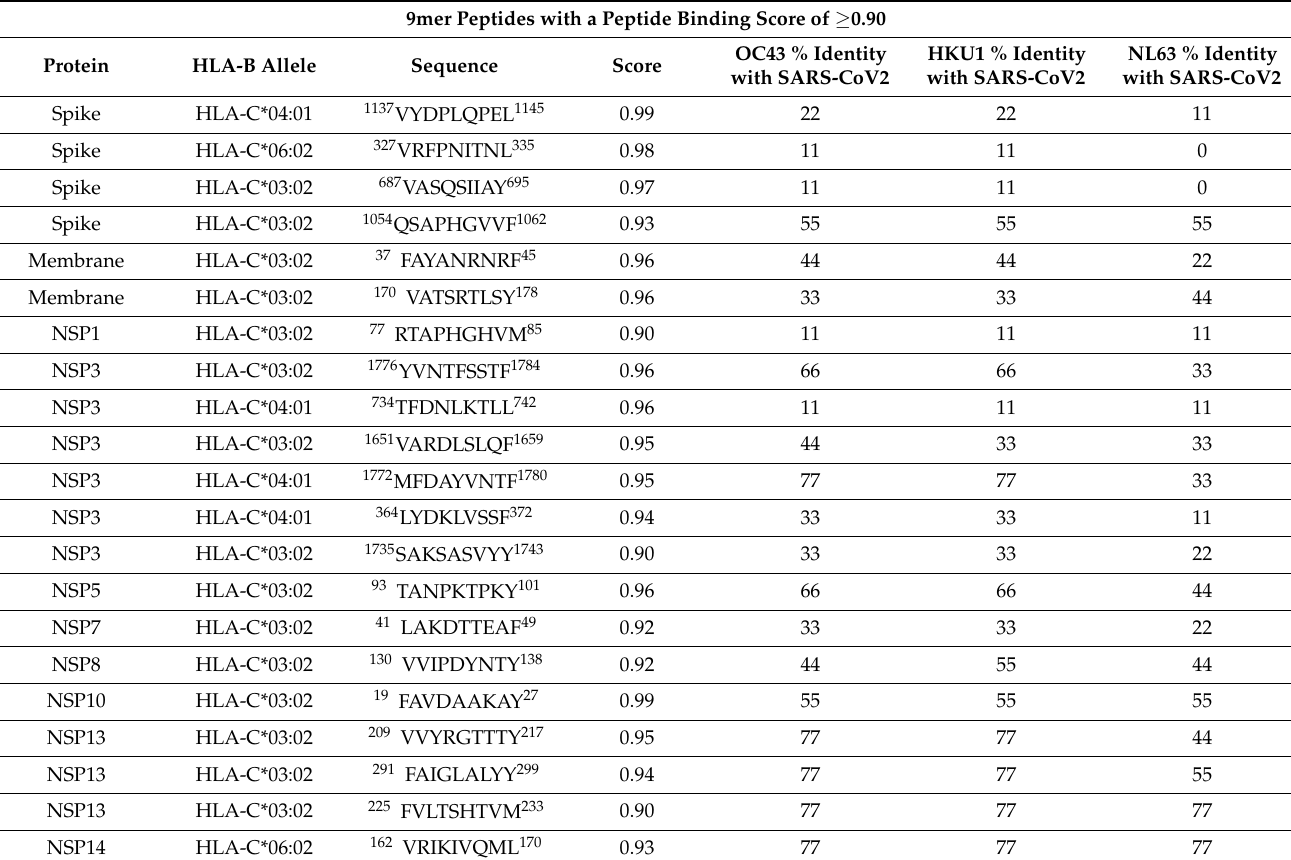
Table 3. Predicted CD8 + epitopes of the SARS-CoV2 virus restricted through HLA-C alleles. 9mer Peptides with a Peptide Binding Score of ≥